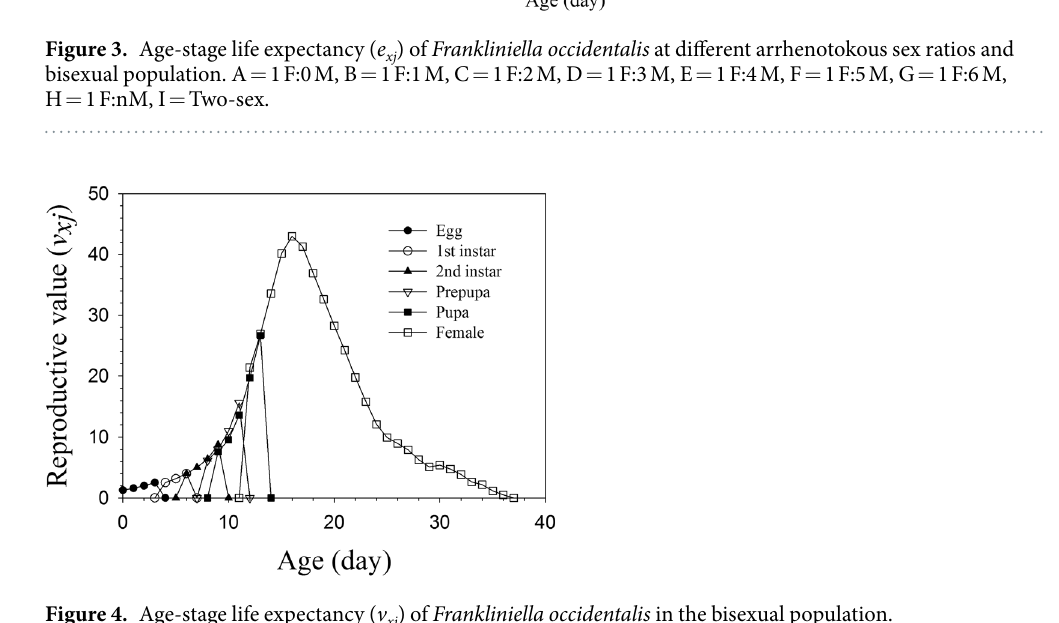
Figure 4. Age-stage life expectancy ( v xj ) of Frankliniella occidentalis in the bisexual